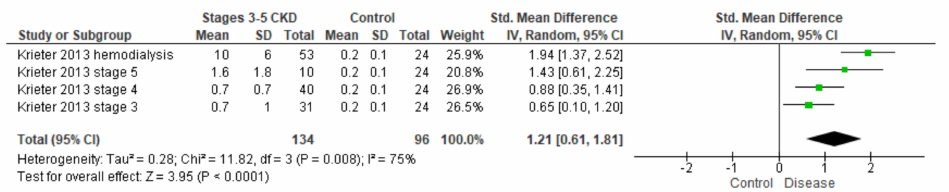
Figure 1. Mean difference analysis using the RevMan program calculates a value to use in the inverse variance analysis [24].